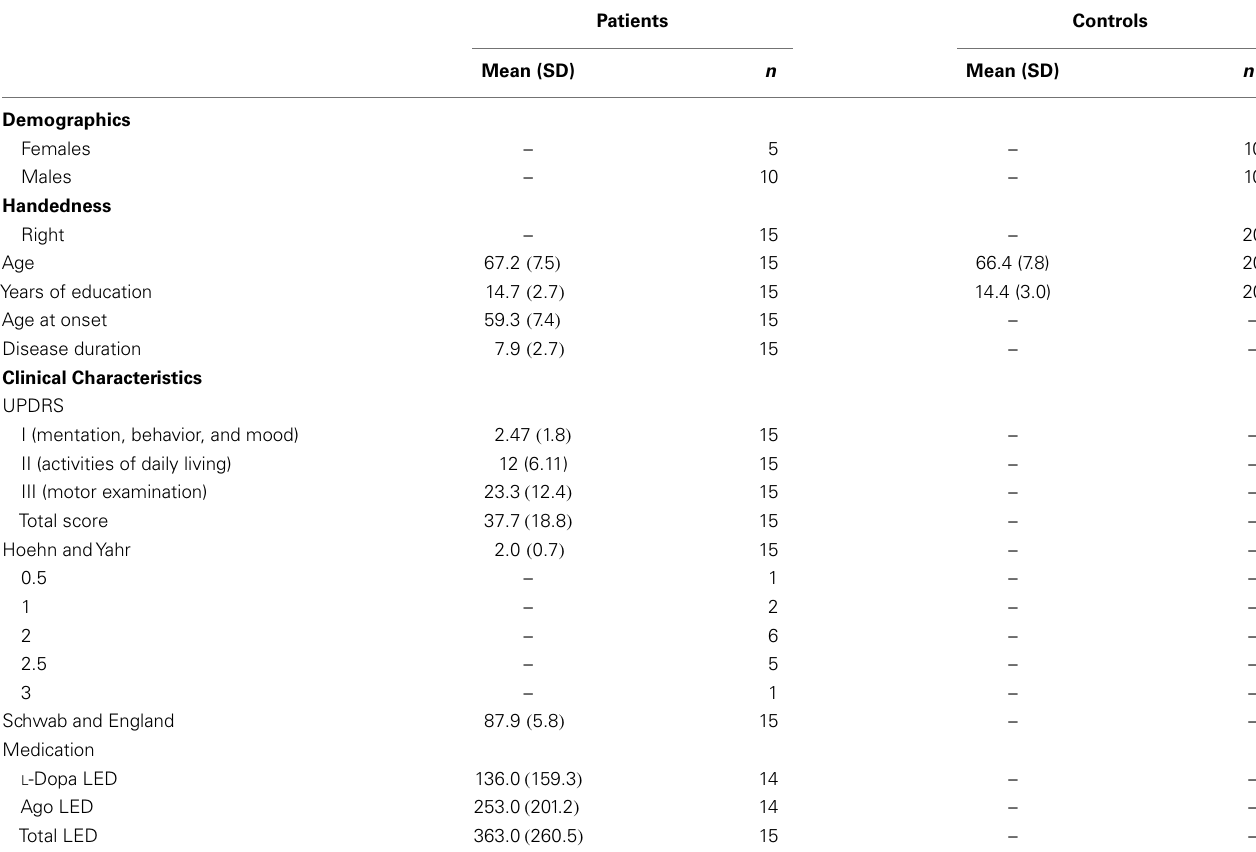
Table 1 | Demographic and clinical characteristics for IPD patients and healthy controls